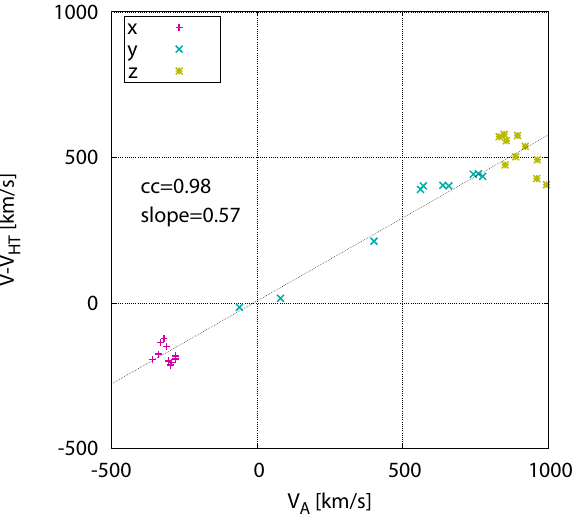
Fig. 5. Wal´en plot in GSM for the interval of 12:07:37-12:09:25 UT. Black, red, and green represent the x, y, and z components, respectively. The velocity of the deHoffman-Teller frame in GSM was found to be (124 , − 199 , − 368)km/s with the correlation coefficient of 0.98.